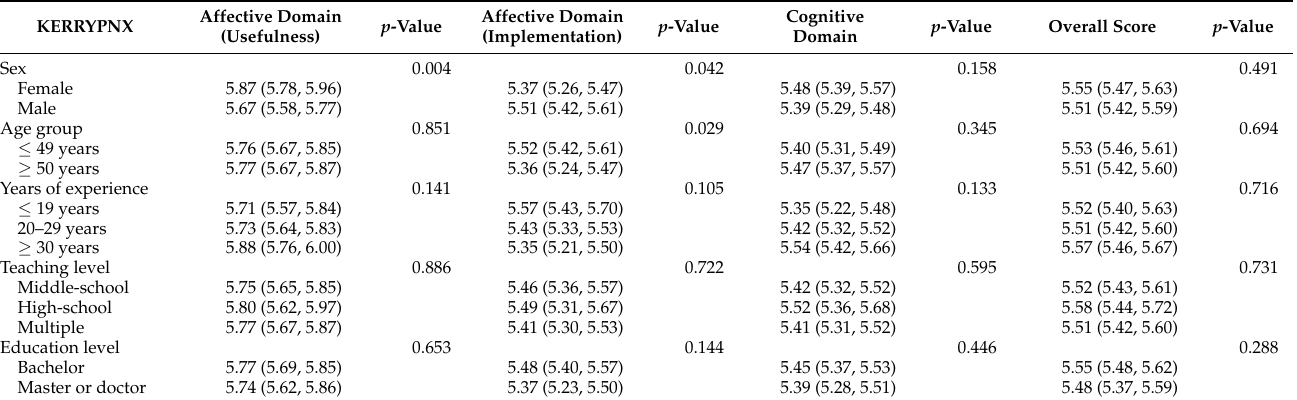
Table 2. Physical education attitude domains of teachers by